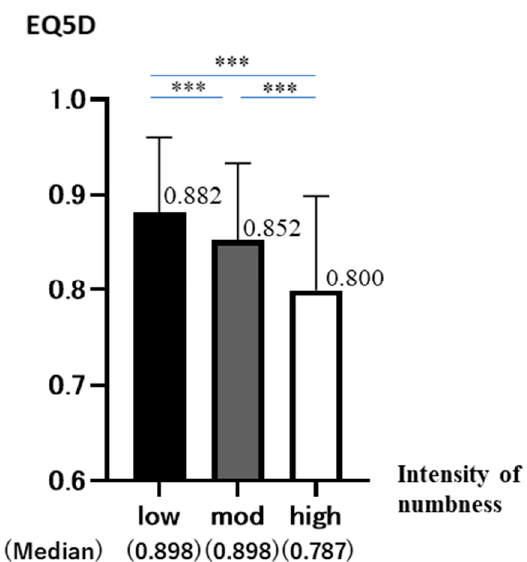
Figure 1. EQ5D is on the vertical axis and numbness intensity is on the horizontal axis (low ( n = 214), moderate ( n = 457), high ( n = 95)). The graph shows the mean and standard deviation (95%CD of EQ5D in each group ( p < 0.001 ***). The 768 patients were divided into spontaneous ( n = 421) and evoked ( n = 208) by the type of numbness. For each, they were similarly divided into three groups (low, moderate, and high) according to the intensity of numbness (Figure 2).